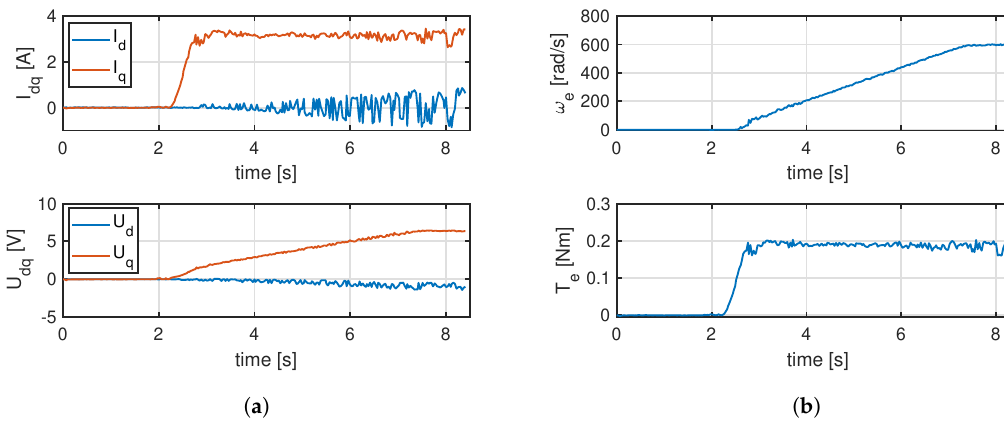
Figure 24. ( a ) dq currents and voltages; ( b ) ω e and T e during start-up sequence of Figure 23.